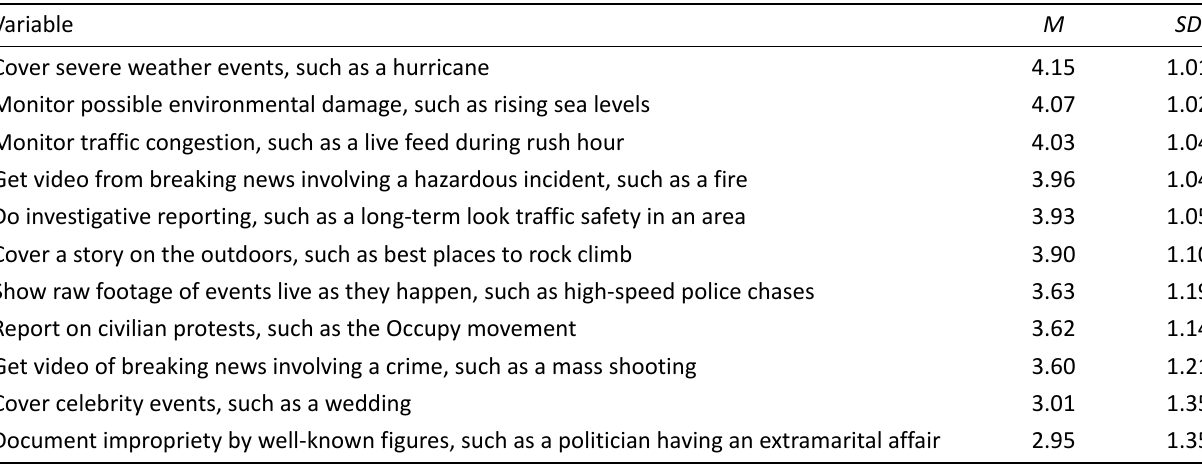
Table 4. Means of openness to drone journalism by index item.